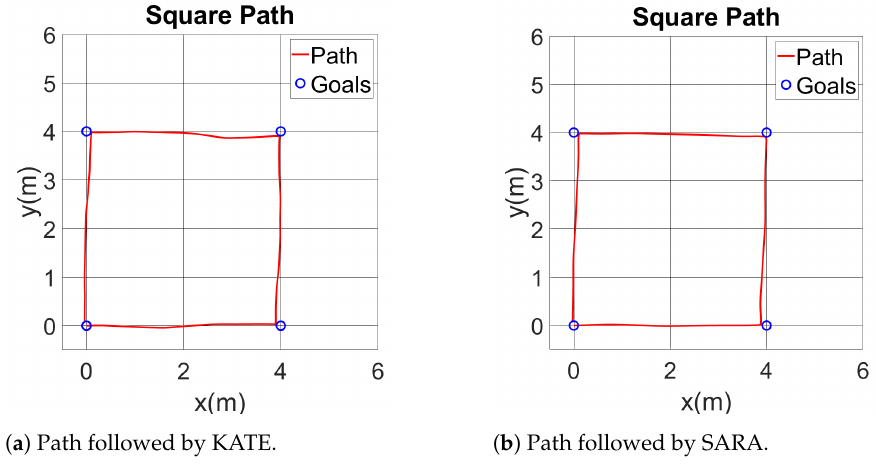
Figure 18. Comparison of square paths followed by SARA and